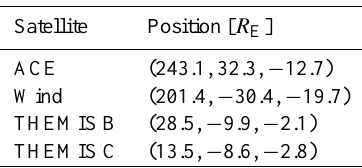
Table 2. Table summarizes spacecraft position in the GSE coordi- nate